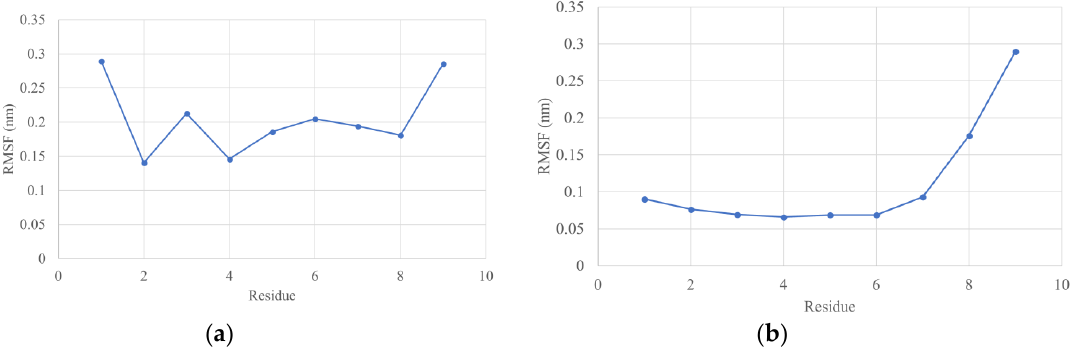
Figure 4. Residual RMSF after 20 ns simulation only for epitope residues. ( a ) WFHDIPLPW; ( b ) WAIYAALTT.